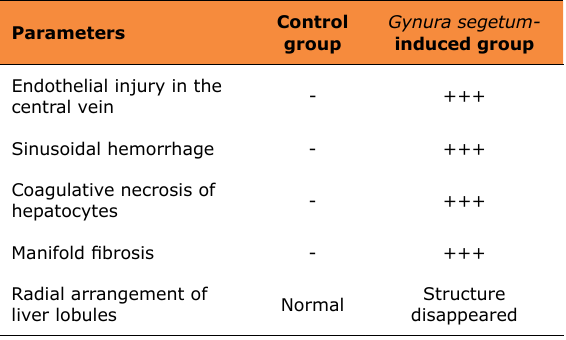
Table 1 - Hepatic sinusoidal obstruction syndrome evaluation for hematoxylin and eosin staining in mice.